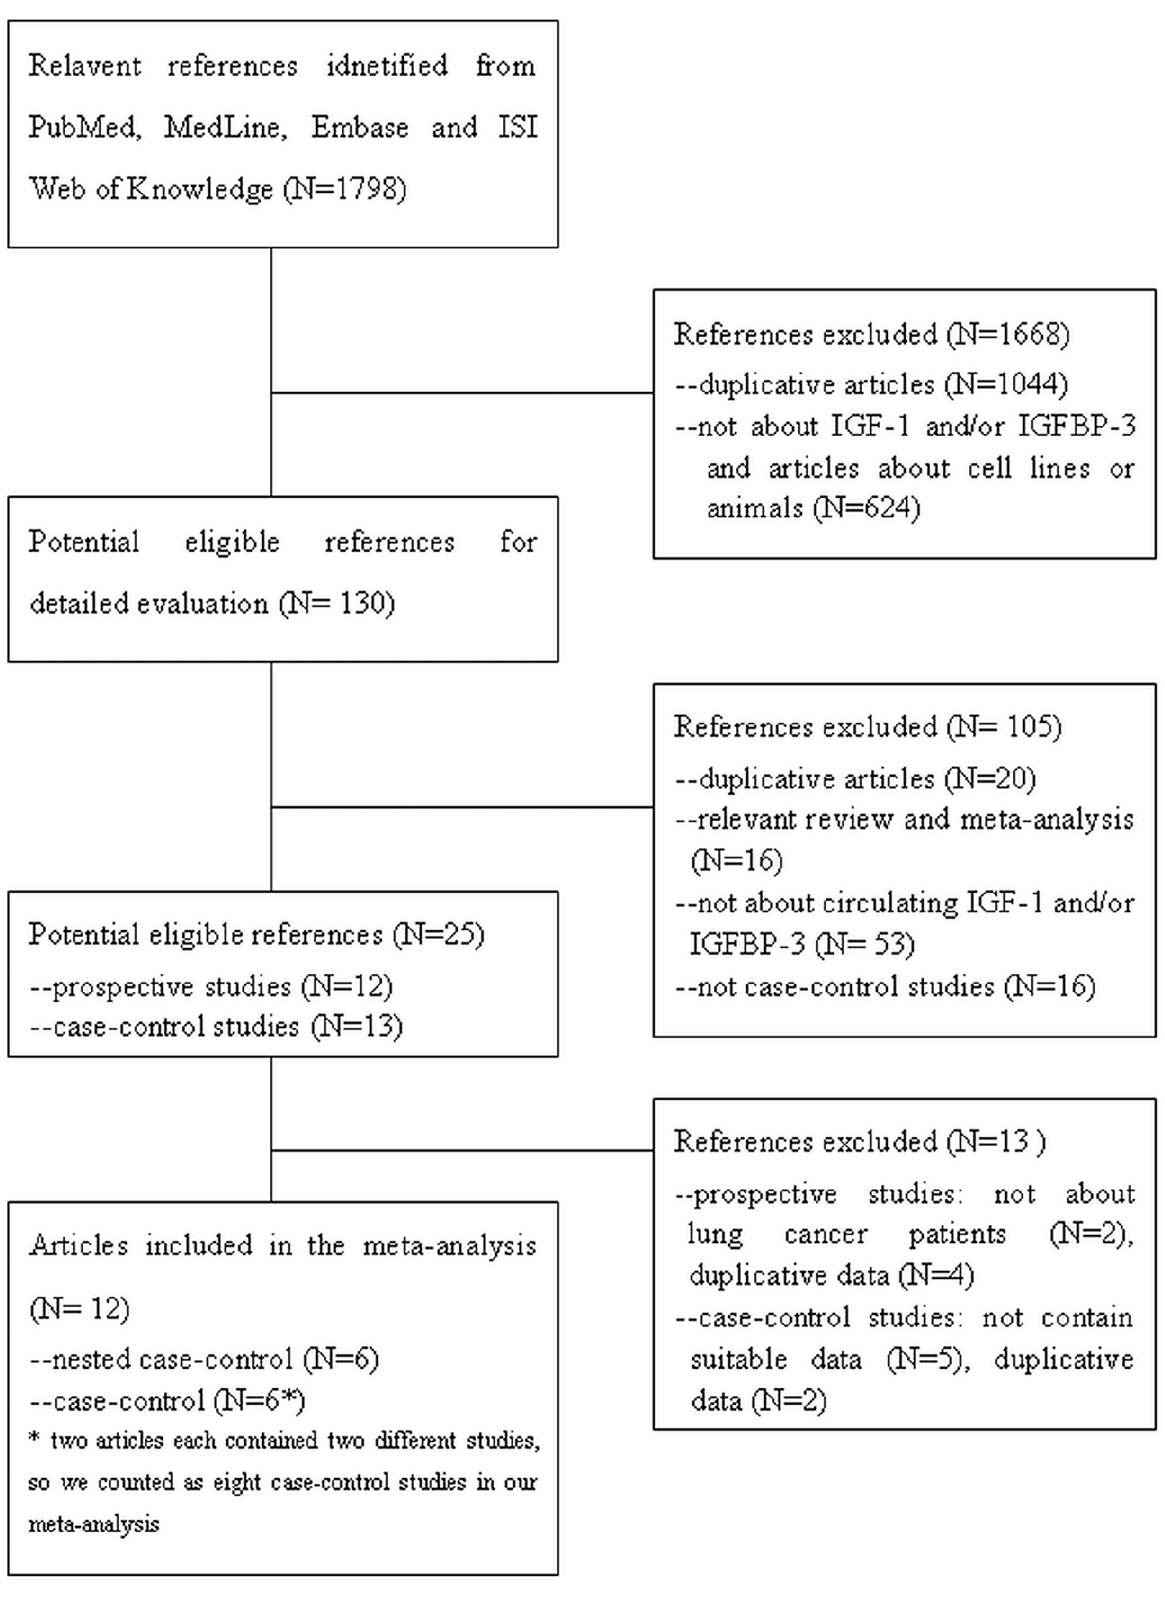
Figure 1. Flow diagram of included studies for this meta-analysis.